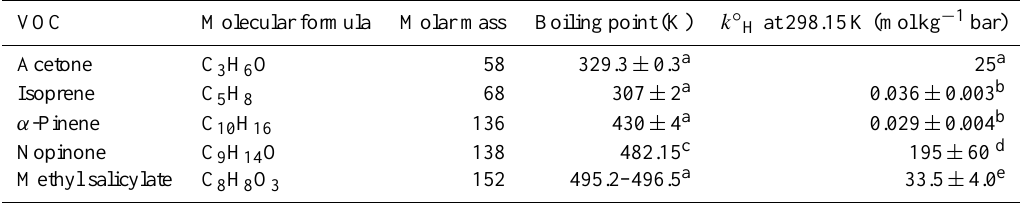
Table 3. Summary of physical and chemical properties of VOCs (acetone, isoprene, α -pinene, nopinone, and methyl salicylate) used in gas standard for transfer efficiency